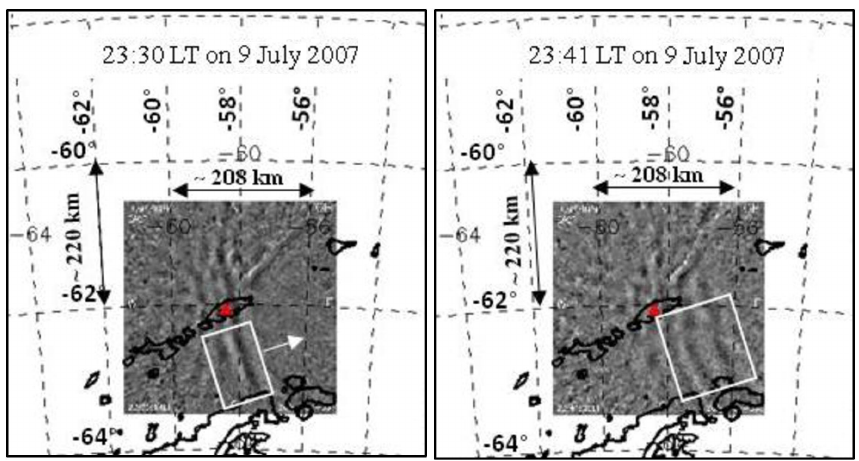
Figure 2. Processed all-sky images of the GW event observed at EACF (red symbol) at 23:30 and 23:41LT (UT − 3) on the night of 9– 10 July 2007, showing the mesospheric front (white box) propagating from west/southwest to east/northeast (arrow direction in the first image). The images were projected at the mesospheric layer in order to have a spatial area as good as 312km × 312km without significant distortion in the unwrapped images.